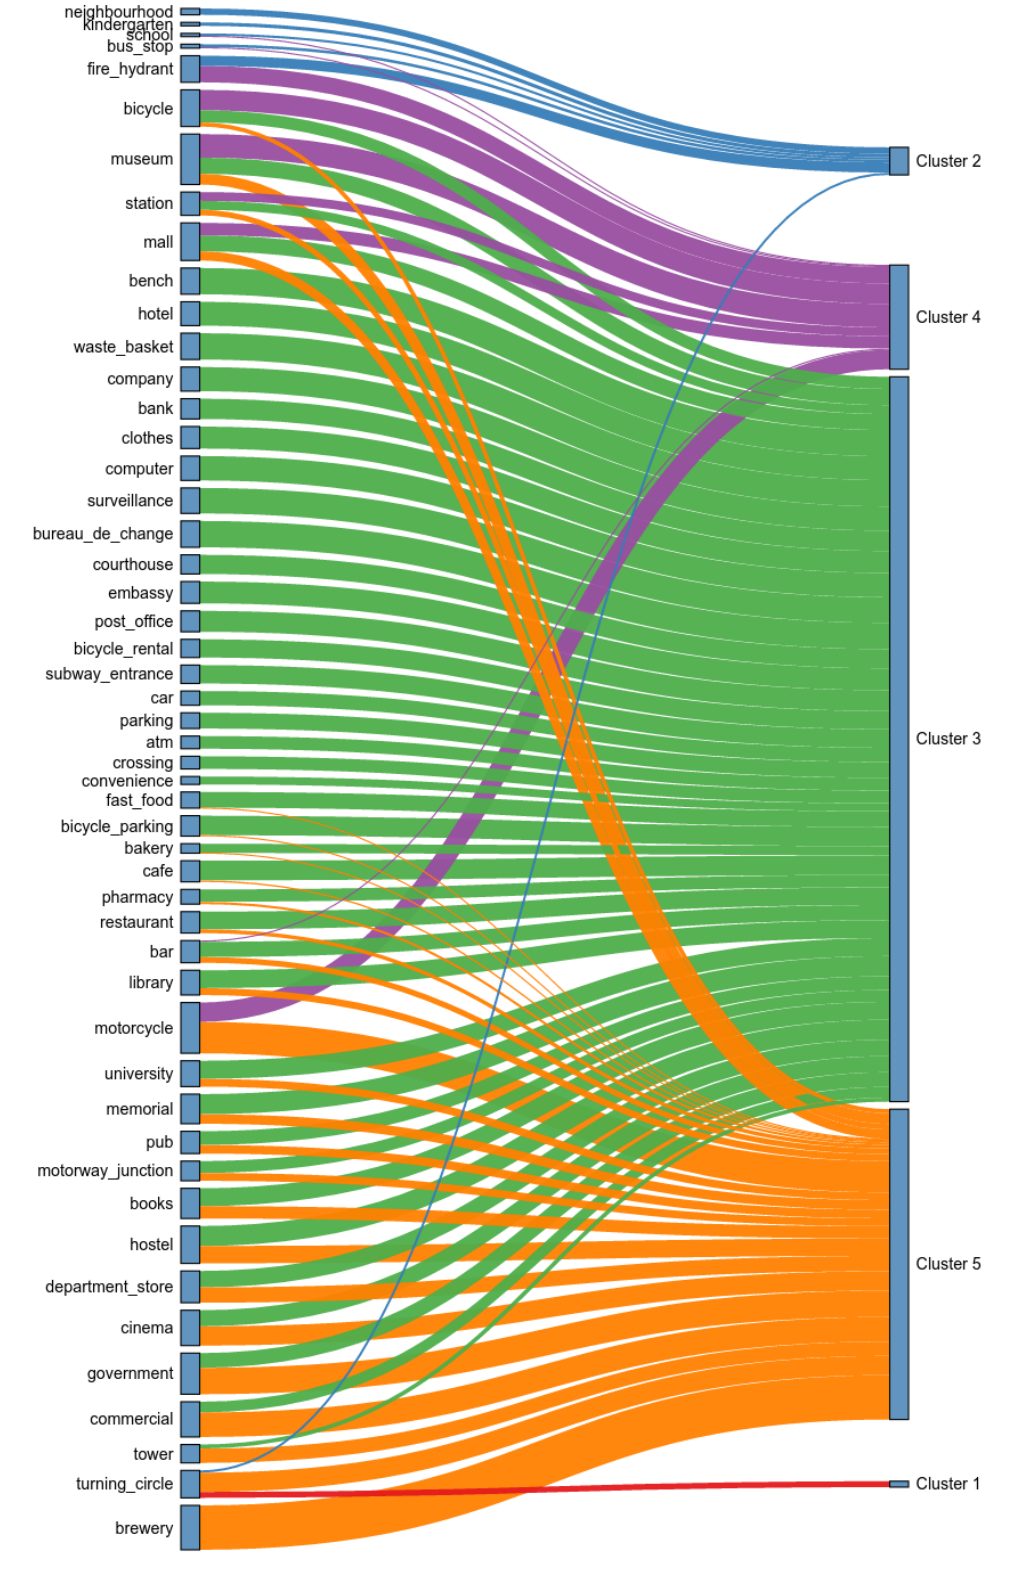
Figure 16. Flow diagram of OSM Points of Interest (POI) sub-categories and their association (through Pointwise Mutual Information (PMI)) with each